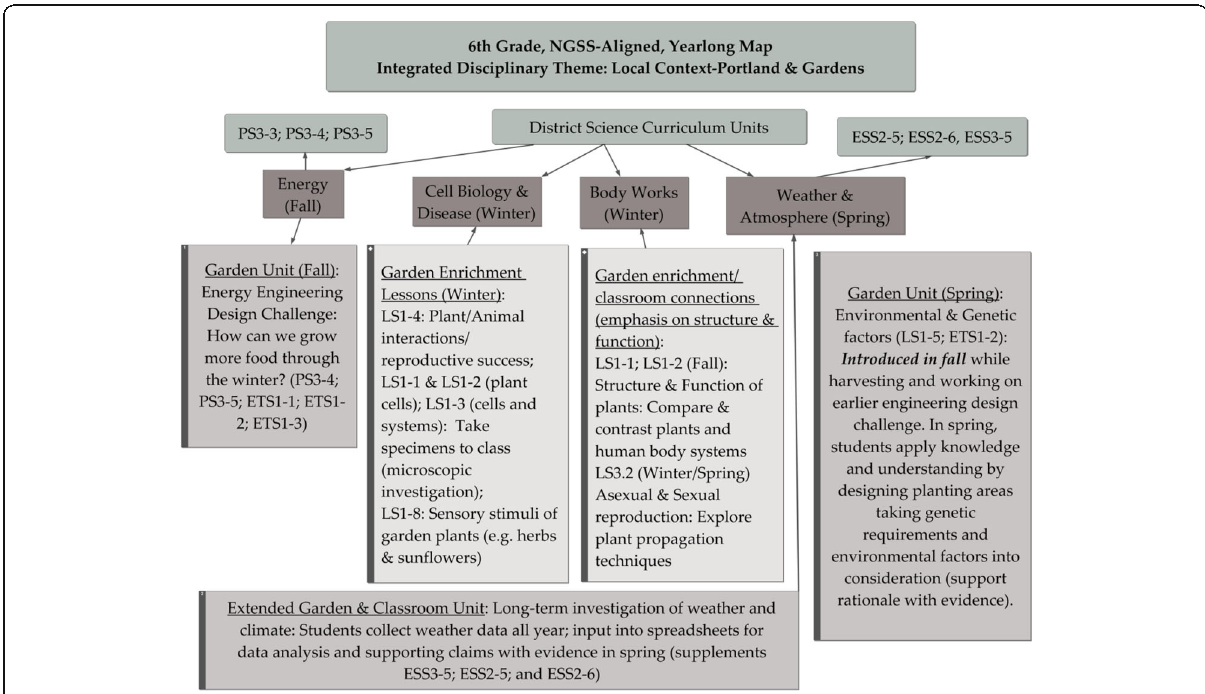
Fig. 1 Yearlong curriculum map, co-created with collaborating teachers outlining learning garden activities and alignment to classroom curriculum. Three units align with the district-adopted science curriculum, and additional enrichment lessons provide hands-on context and application for disciplinary concepts. By emphasizing extended units of instruction, this curriculum can be used for application and enrichment of school curriculum, and/or as stand-alone garden curriculum. (NGSS=Next Generation Science Standards. Other abbreviations are consistent with those used in the NGSS: PS=Physical science; LS=Life science; ESS=Earth & Space science; ETS=Engineering, Technology, and Application of Science. Numbers following abbreviations indicate the disciplinary core ideas described in NRC,